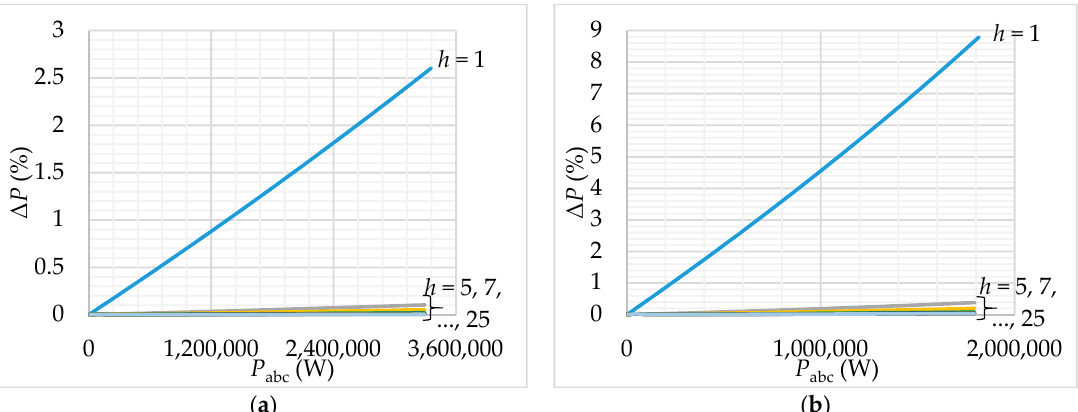
Figure 14. The dependence of increasing APLs from three-phase active power consumption for ACSR 95/15: ( a ) the length of 5 km; ( b ) the length of 30 km.